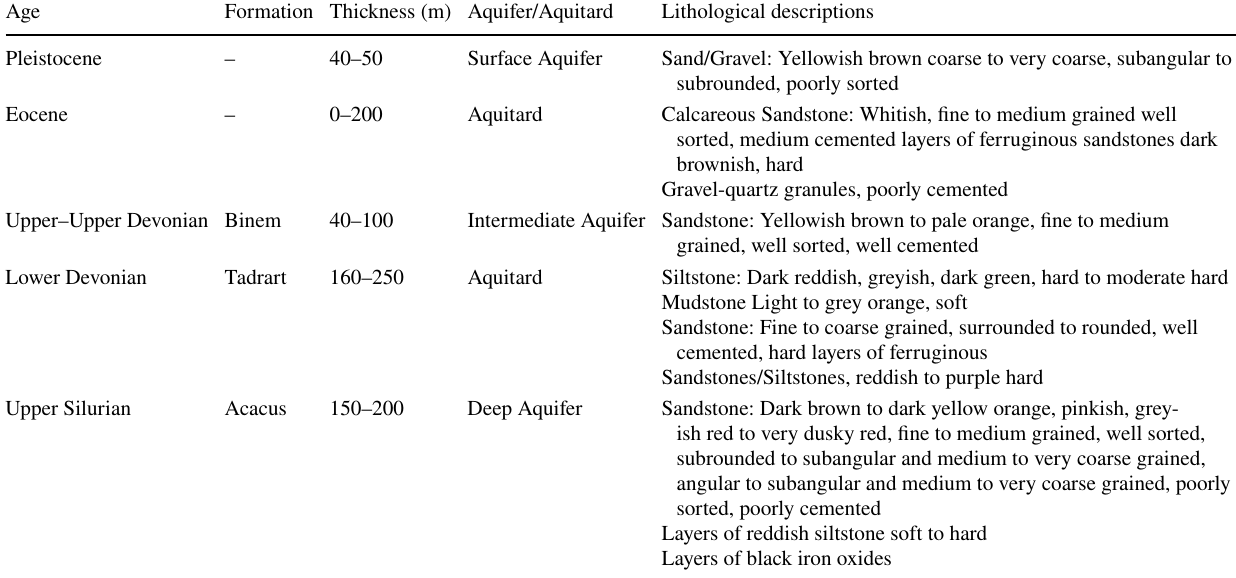
Fig. 2 Tazerbo water wellfield location map (Geological basins based on Hallett 2002) need to show regional groundwater piezometric contours on left hand diagram Table 2 Stratigraphic geological succession of the Tazerbo wellfield (GMMP and LAVALIN